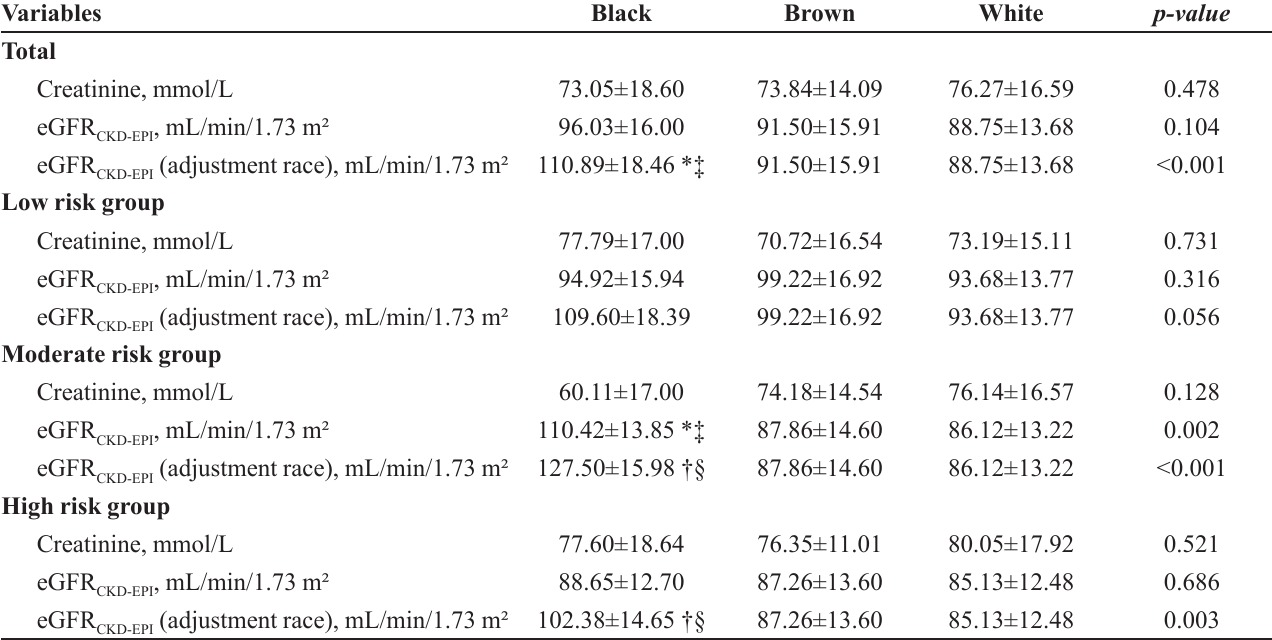
TABLE III ‑ Distributions of races and kidney function among the groups (FRS) Variables